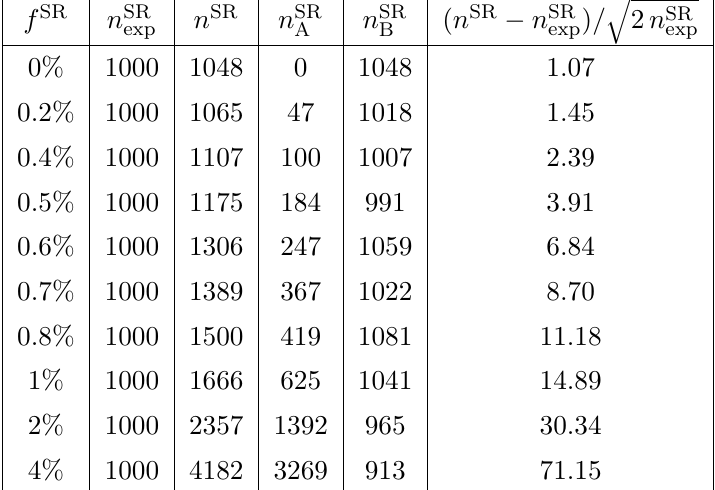
and n SR ). The latter A B